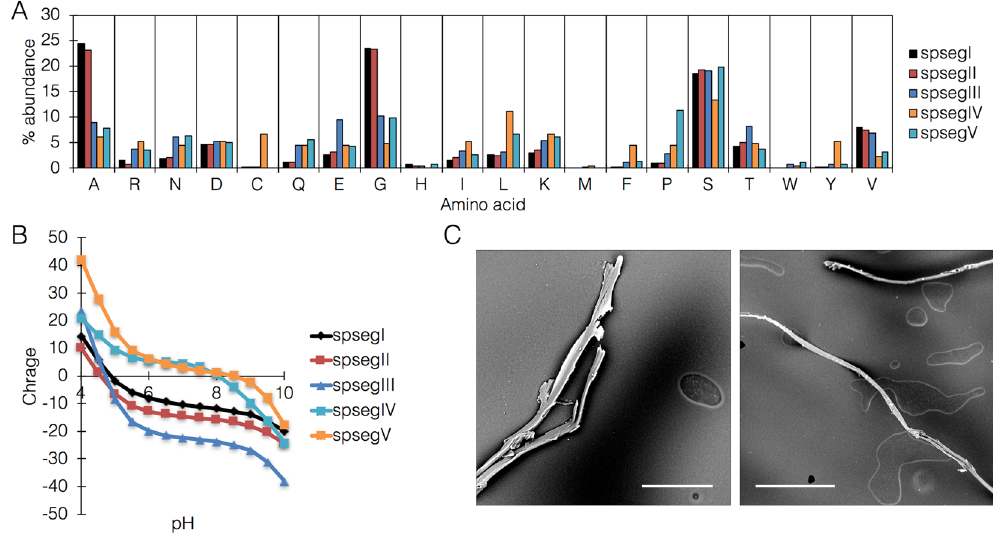
Figure 3. Silk protein analysis and self-assembly. ( A ) amino acid distribution in all 5 silk protein segments. ( B ) calculated net charge on protein surface. ( C ) SEM images showing assembled protein fibers following concentration by dehydration and acidification to approximately the calculated isoelectric point. Size bars = left, 50 μ m; right, 100 μ